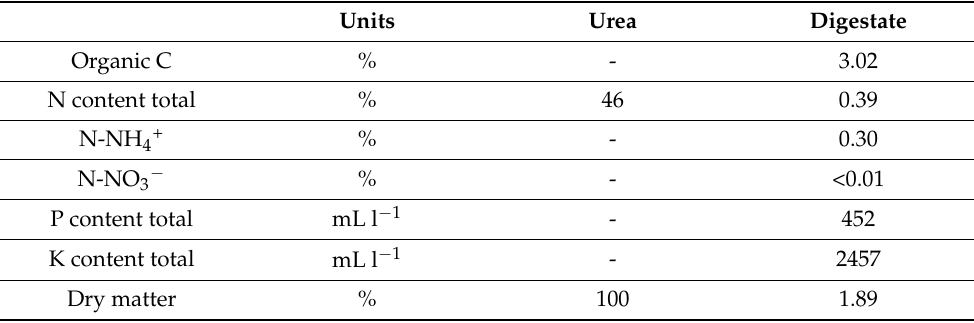
Table 1. Elemental characterization of fertilizers (urea and digestate) used in this experiment. Units